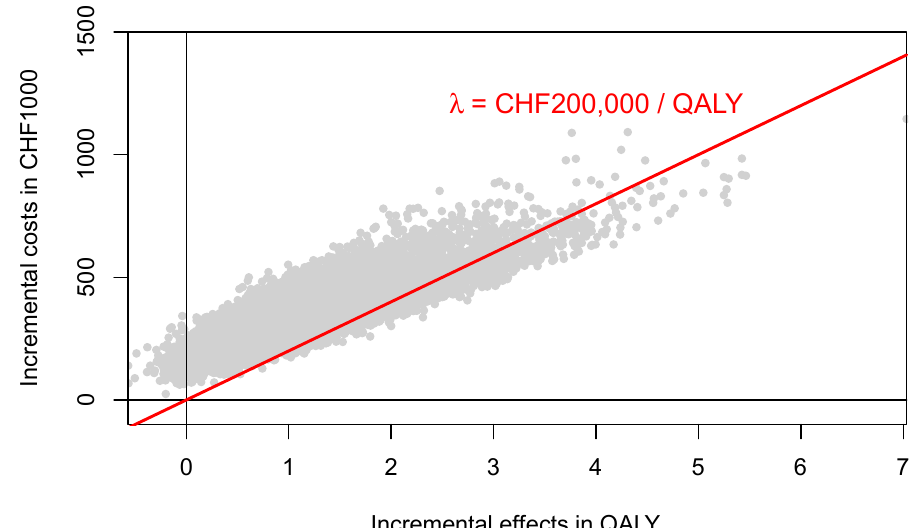
Figure 4. Joint distribution of total costs and effects of PALLET (palbociclib and letrozole) versus LET (letrozole) in patients with metastatic ER + HER2- breast cancer. One Swiss Franc (CHF) corre- sponds to $US 1.07.